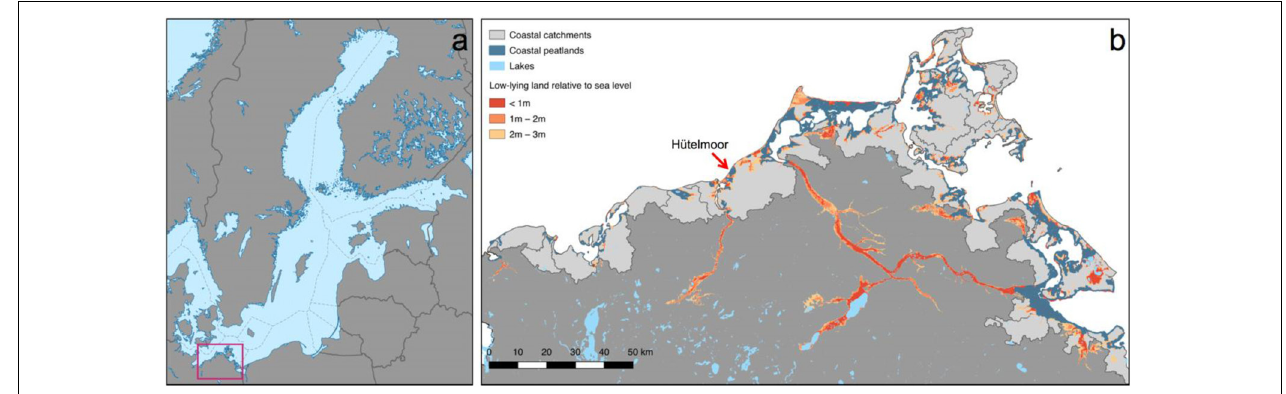
FIGURE 1 | (a) Map of the Baltic Sea with the extent of the region to the right represented by a purple rectangle; (b) The Baltic Sea coast in the north-east of Germany with low-lying areas and coastal peatlands. Low-lying areas reach relatively far into the land and the wide river valleys are filled with peat. Coastal peatlands occur in the lowest-lying areas ( < 1 m). Note the coastal catchments (light gray) that are not connected to a river basin and discharge directly into the sea. Country borders were retrieved from www.gadm.org. Base data for the map in b and all other maps were provided by www.geoportal-mv.de.